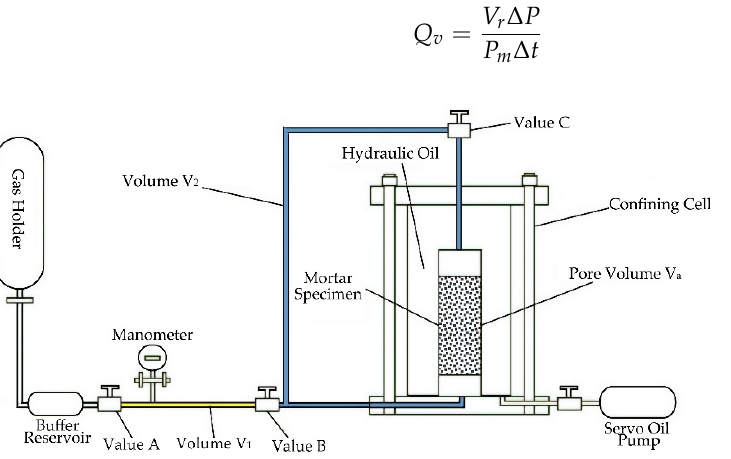
Figure 1. Schematic diagram of the gas permeability and porosity measurement device.